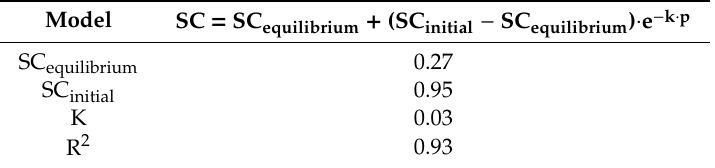
Table 2. Mathematical modeling of serum cloudiness (SC) as a function of the homogenized pressure (0–100 MPa) in lily pulp.